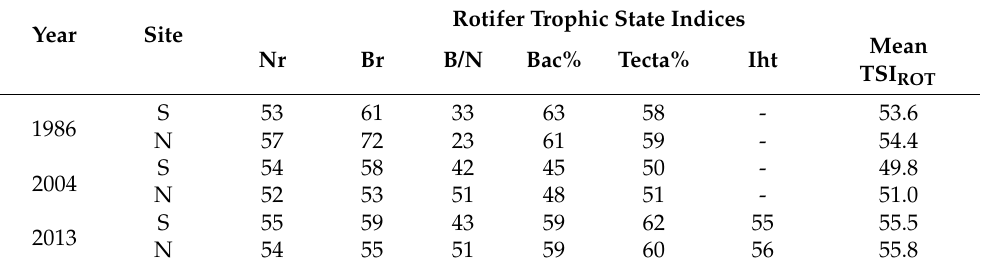
Table 2. Values of rotifer trophic state indices calculated with data from subsequent years of research (S–the site in the southern basin of the lake, where the pipeline is located; N–the site in the northern basin of the lake). Rotifer trophic state indices were based on rotifer numbers (Nr), total rotifer community biomass (Br), percentage of bacterivores in total rotifer numbers (Bac%), the ratio of biomass to numbers (B/N), the percentage of the tecta form in the population of Keratella cochlearis (Tecta%), and the contribution of species in the indicatory group numbers that indicate a high trophic state